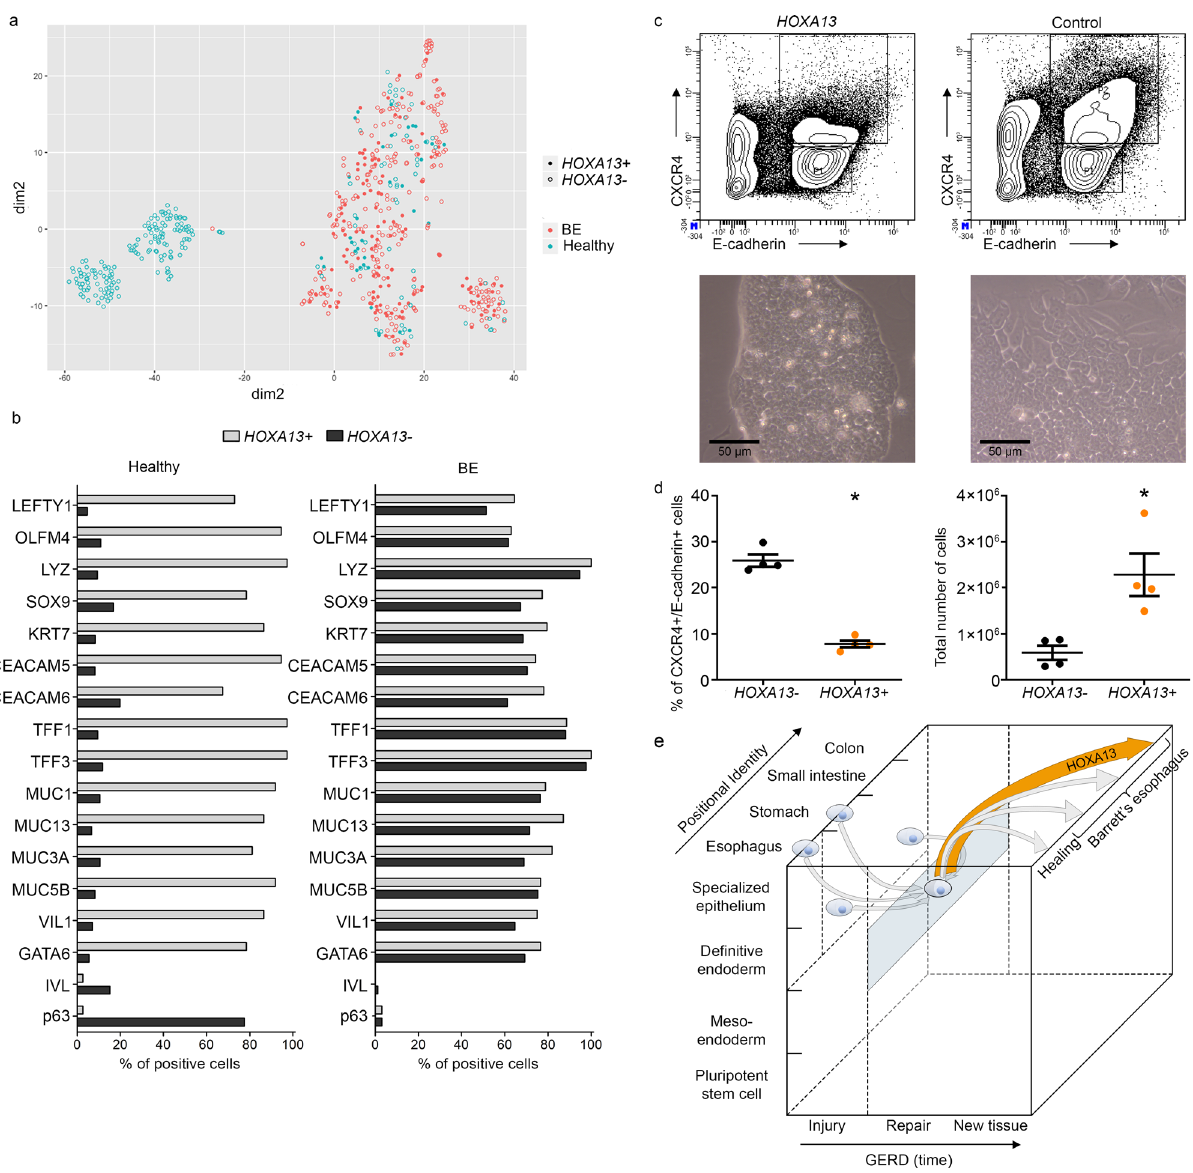
Fig. 5 HOXA13 cellular expression modulates cell fate. a HOXA13 + cells of normal esophagus cluster together with BE cells in t-distributed Stochastic Neighbor Embedding ( T-SNE) plot based on single cell RNA expression pro fi ling 21 . b Analysis of single cell RNA seq data revealed that in contrast to HOXA13 − cells, HOXA13 + cells express submucosal gland markers, Barrett ’ s esophagus (BE) markers and have decreased expression of squamous markers (p63, IVL) in healthy esophagus. This difference is not observed in BE. n = 846 of HOXA13 − cells in healthy esophagus, n = 37 of HOXA13 + in healthy esophagus, n = 263 HOXA13 − cells in BE, n = 132 of HOXA13 + cells in BE. c HOXA13- overexpressing de fi nitive endoderm is relatively resistant to terminal differentiation. Mouse embryonic stem cells (mESC) cells with and without forced HOXA13 expression were differentiated from pluripotent stem cells to de fi nitive endoderm. The percentage of differentiated de fi nitive endoderm cells, de fi ned as CXCR4 + /E-cadherin + cells, was analyzed by FACS analysis (upper panels). Lower panels (representative light microscopy images) show morphological differences in cultures of HOXA13 overexpressing and wildtype mESCs upon differentiation to de fi nitive endoderm, which induces a fl attening of cell layers, with larger and irregular shaped cells. d Quanti fi cation of FACS analysis results indicates that the percentage of CXCR4 + /E-cadherin + cells is decreased in HOXA13 -overexpressing cell cultures under differentiation conditions ( p < 0.0001). HOXA13- expressing cells expand faster during the differentiation process compared to control cells (total number of cells increased) ( p = 0.0135). Mean ± SEM, *** p < 0.001, n = 4 independent experiments, t -test (two-tailed). e Model of cellular identity in BE development. The X -axis represents time (hypothetical units) following exposure to GERD-inducing agents. Y -axis shows differentiation during embryology and pathology. Z -axis indicates the positional identity of GI-tract tissues. Several theories exist regarding the cell of origin of BE: they may be fully differentiated esophageal or stomach cells, or less differentiated cells within these organs (depicted by the 4 cells on the Y – Z plane). Irrespective of its location or differentiation state, this cell or origin might lose its correct positional identity or maintain its aberrant positional identity and resembles a de fi nitive endoderm like cell. This is visualized by the blue rectangle harboring the cell with the thicker blue contour. For the model of cellular identity in BE, our data suggest that HOXA13 expressing clones in the GEJ, depicted in orange, may outcompete clones with another positional identity, providing an explanation for the distal phenotype observed in